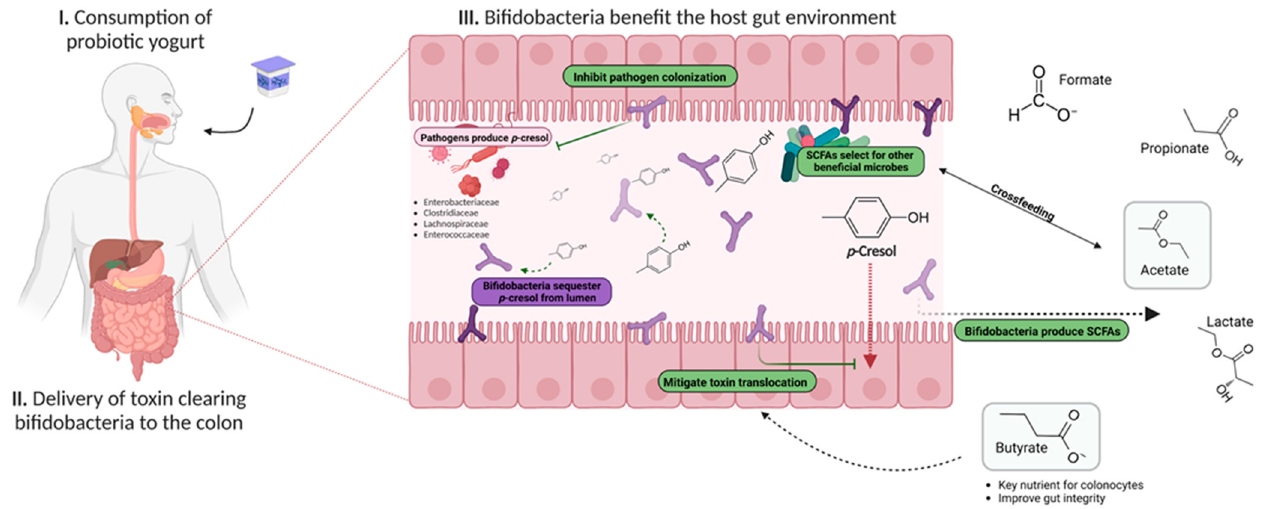
Figure 4. Summarizing the influence of bifidobacteria on promoting a healthy gut microbiota in CKD patients. The red box indicates the toxin-producing function of the dysbiotic gut microbiota in CKD patients, whereas green and purple boxes represent the known bifidobacterial mechanisms of action and the proposed function of p -cresol clearance, respectively.